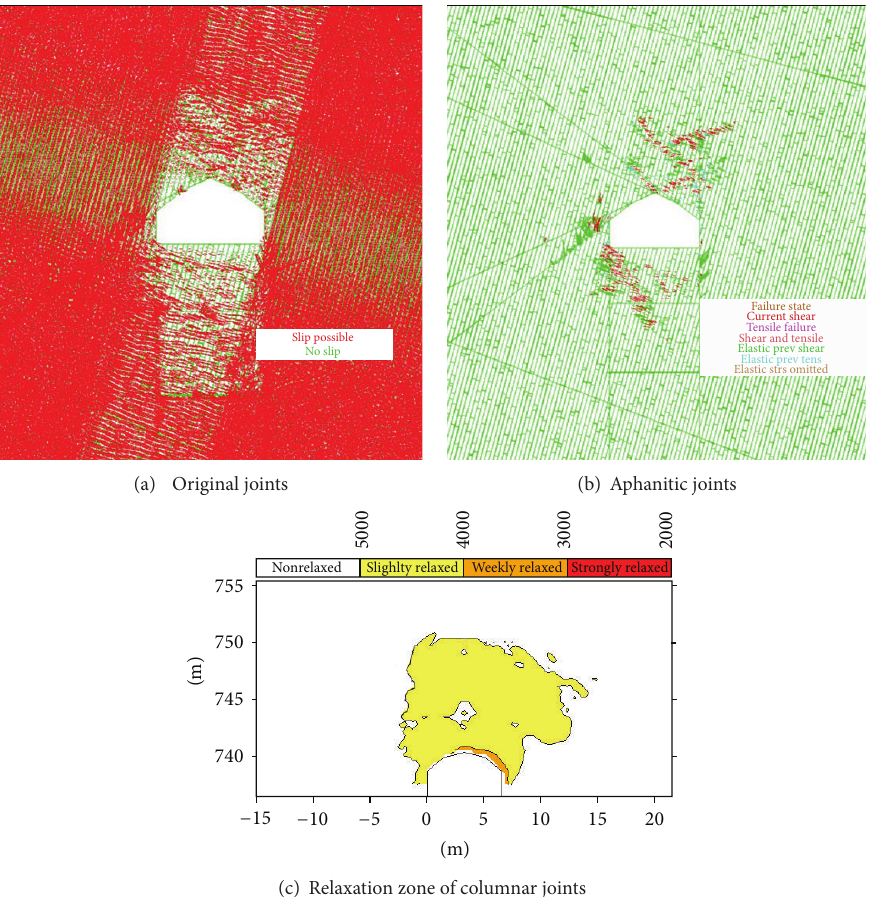
Figure 8: Relaxation zones of joints after excavation of the first